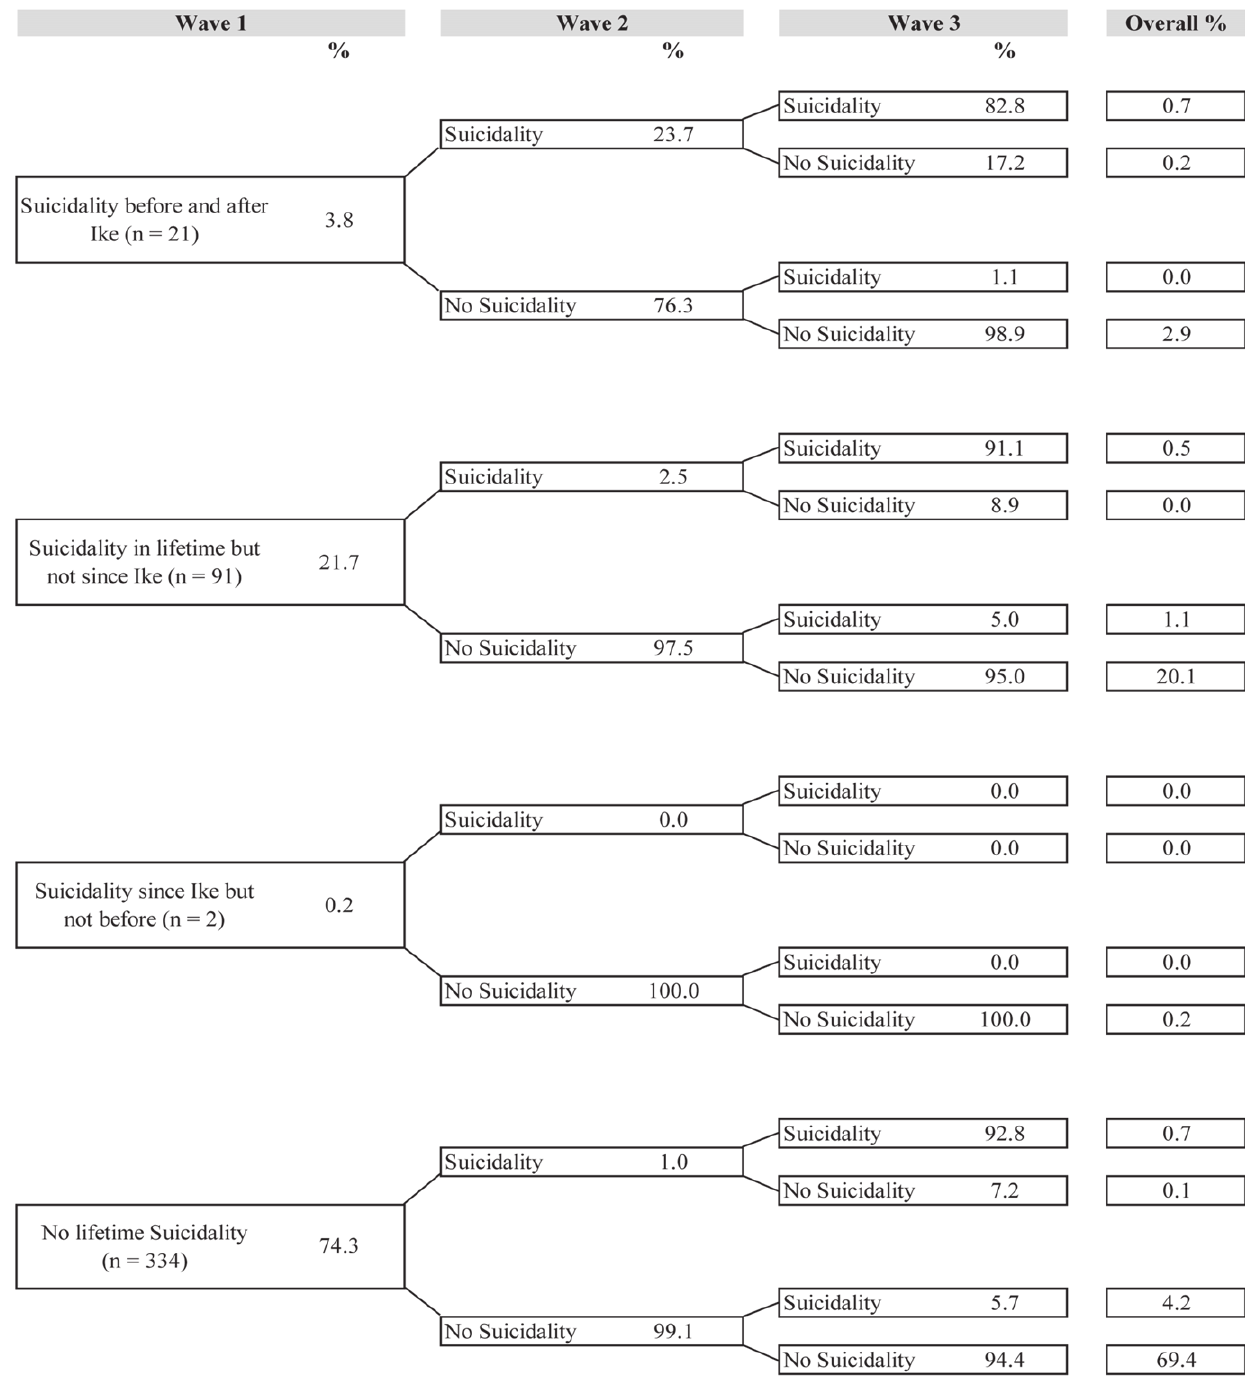
Figure 5. Trajectories of suicidality (n=448). doi:10.1371/journal.pone.0038964.g005 The past-month prevalence of GAD at Wave 1 (3.1%) is consistent with the prevalence of this disorder observed in a recent study of Vietnamese adults affected by a typhoon (2.2%; [10]); however, it is slightly lower than that observed in a study of adults affected by the 2004 Florida hurricanes (5.5%; [9]). The past 14 to 18-month prevalence of GAD (2.7%) was comparable to the 3.1% past 12-month prevalence of this disorder in the general U.S. adult